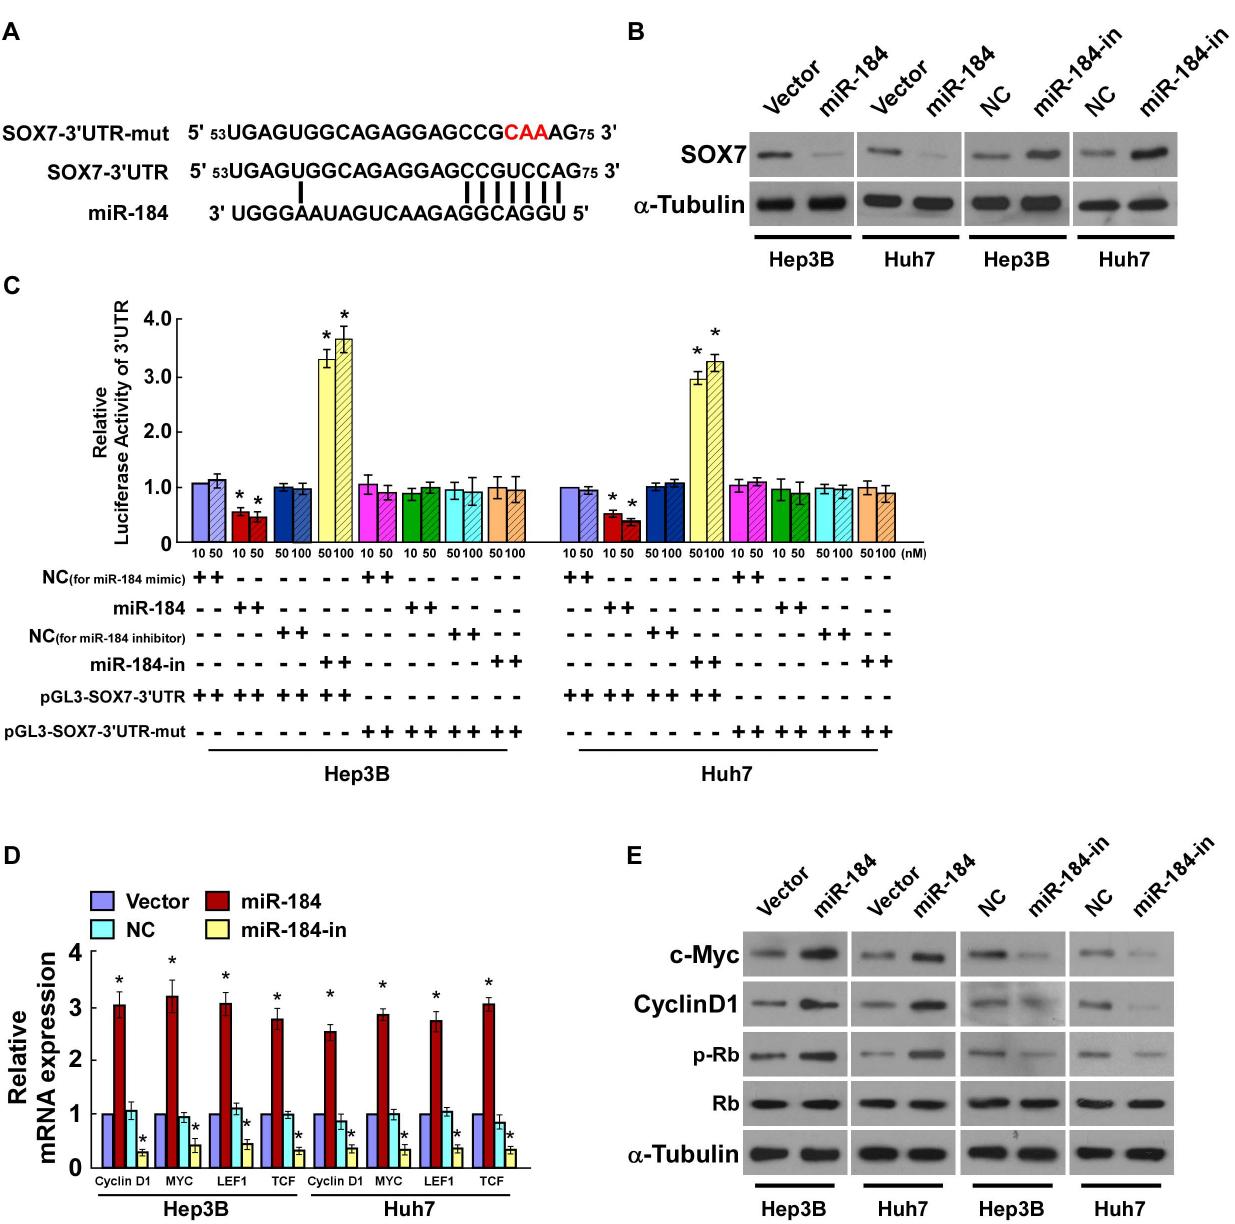
Figure 4. MiR-184 directly targets the 3 9 -UTR of SOX7 mRNA. A . Schematic representation of the mature miR-184 sequence, miR-184 target site in the 3 9 -UTR of SOX7 mRNA and a 3 9 -UTR mutant of SOX7 mRNA containing three altered nucleotides in the putative target site (SOX7-3 9 UTR- mut). B . The expression levels of SOX7 protein in HCC cells overexpressing miR-184 or transfected with miR-184 inhibitor, compared with control cells, by western blotting 48 hours after transfection; a -Tubulin served as the loading control. C . Luciferase assay of pGL3-SOX7-3 9 UTR or pGL3-SOX7- 3 9 UTR-mut reporter cotransfected with different amounts (10, 50 nM) of miR-184 mimic in indicated cells, or different amounts (50, 100 nM) of miR- 184 inhibitor, compared with negative control (NC). D . Real-time PCR analysis of the mRNA expression of genes, MYC , CyclinD1, LEF1 and TCF ,